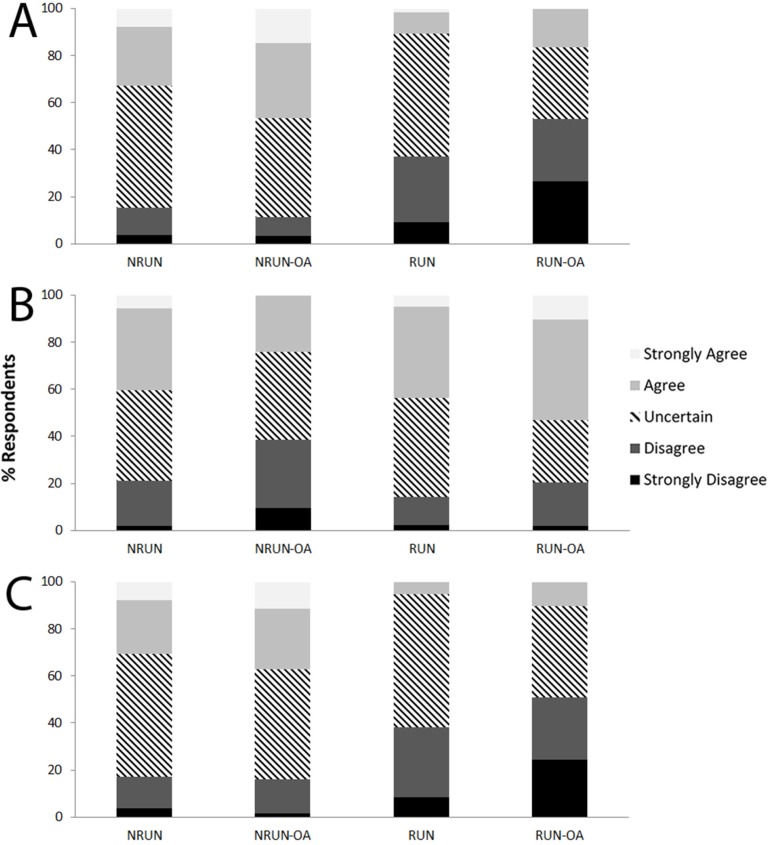
Perception of non-runners and runners about running and the progression of knee osteoarthritis.(A) “People with knee osteoarthritis who continue to run will sustain greater knee cartilage damage leading to more severe OA”; (B) “It is fine for people who have OA to run as long as they don’t have symptoms on the day they go running”; (C) “A person with knee osteoarthritis who keeps running regularly will speed up the need for joint replacement surgery (knee arthroplasty)”.